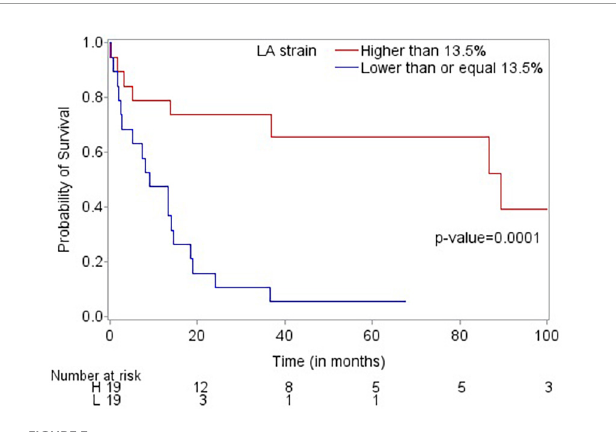
FIGURE3 Kaplan-Meier plot demonstrating that LA strain > 13.5 is associated with improved overall survival.